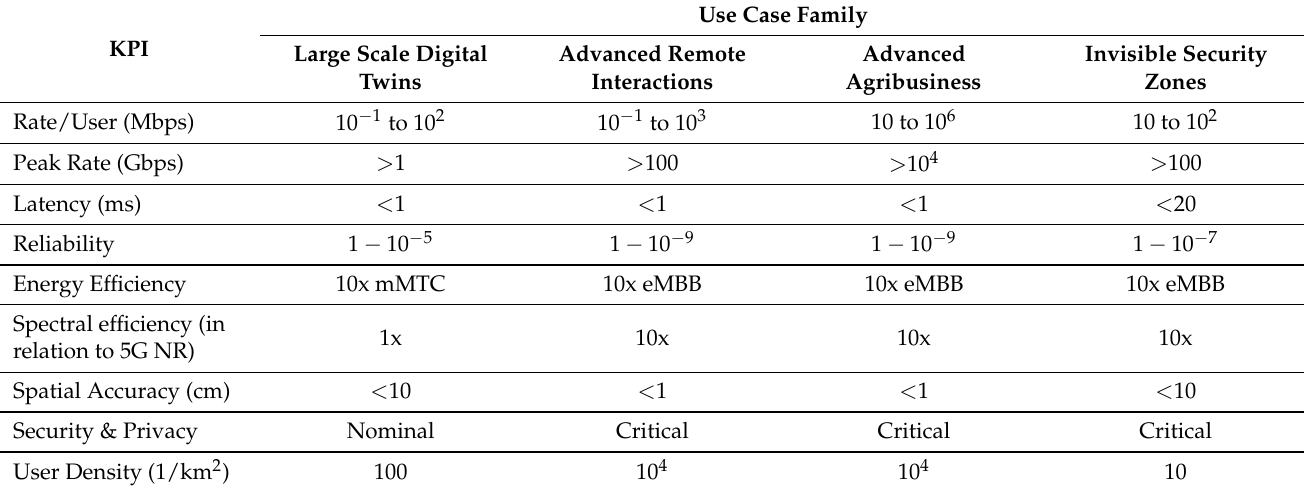
Table 1. Key performance indicators of the innovative use cases of 6G